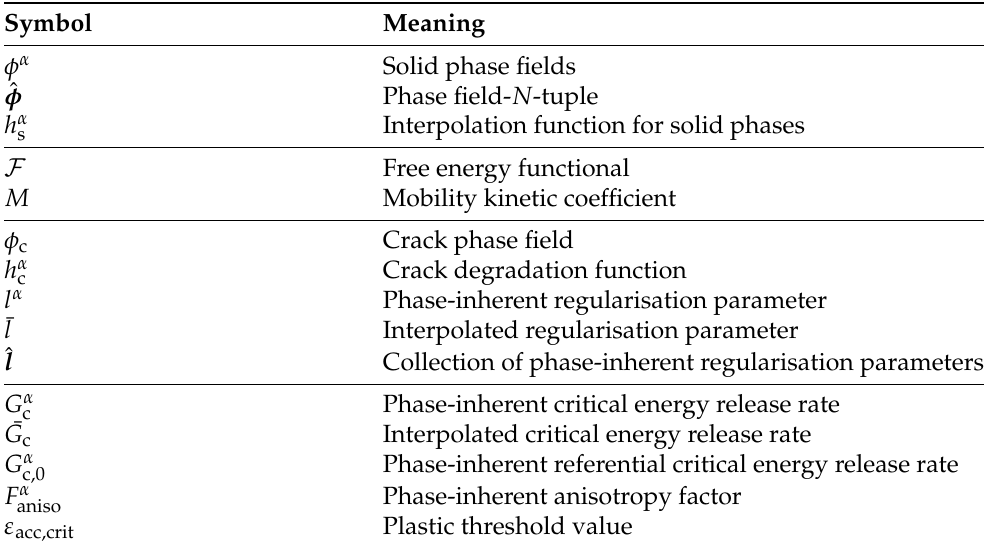
Table 2. Summary of the most important symbols, categorically